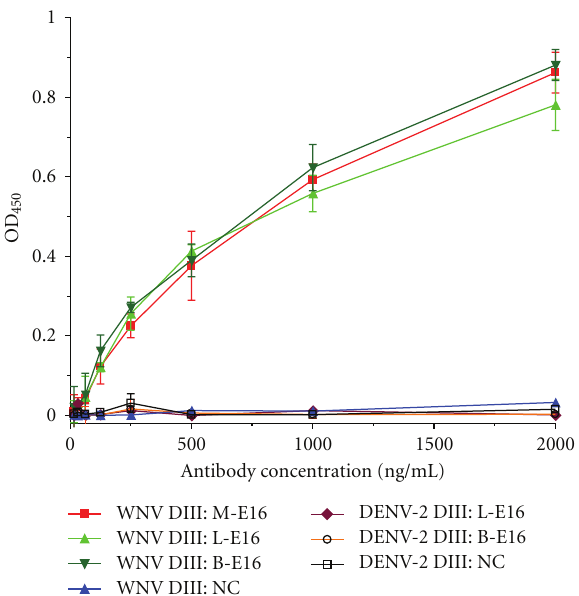
Figure 4: Highly specific binding of plant-derived E16 to WNV DIII antigen. WNV DIII or DENV-2 DIII antigen produced in E. coli was immobilized on an ELISA plate and incubated with increasing concentrations of lettuce or N. benthamiana -derived E16 mAb (L-E16 or B-E16), mammalian cell-derived E16 (M-E16, positive control), or a negative control generic human IgG (NC). A HRP- conjugated anti-human IgG was used to detect mAbs bound to DIII antigens. Mean ± SD of OD 450 from three independent experiments are